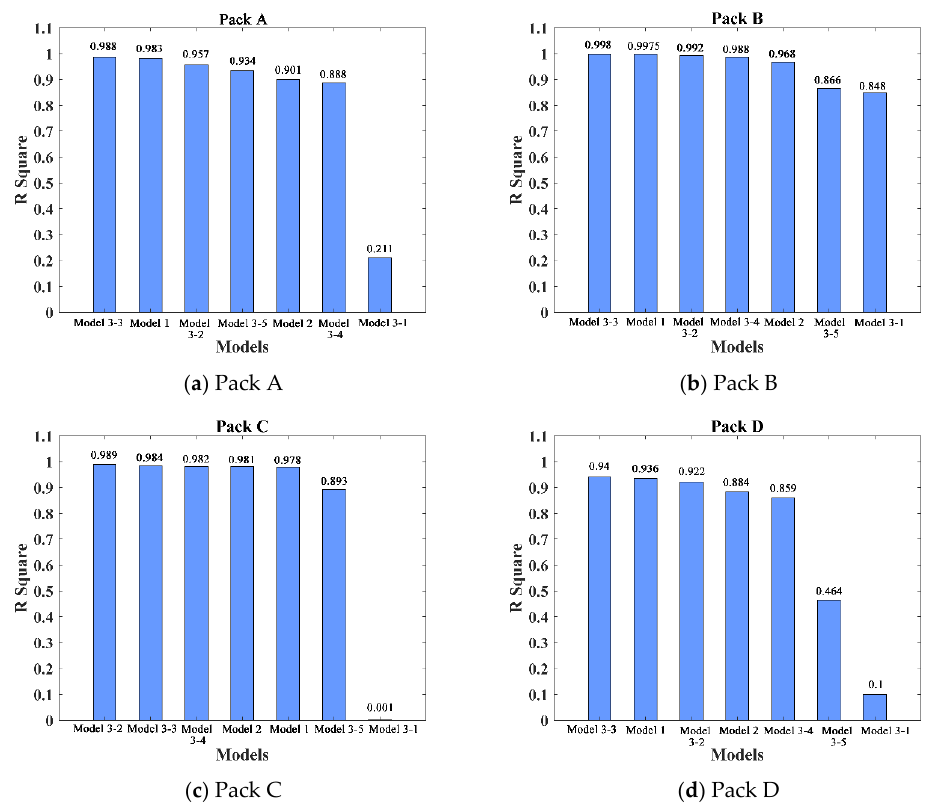
Figure 6. The results of the fitting effects of each model for the four battery packs: ( a ) Pack A, ( b ) Pack B, ( c ) Pack C, ( d ) Pack D.